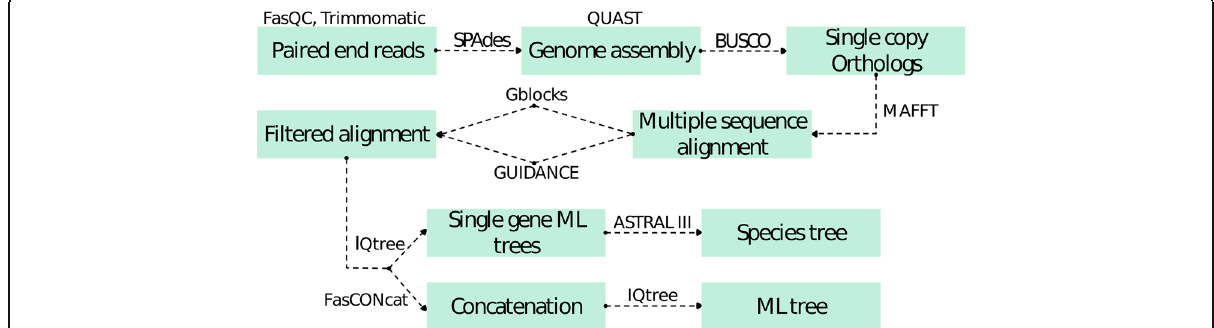
Fig. 1 Flow chart reporting the bioinformatic pipeline used for the analyses. Input and output of the pipeline are reported inside the boxes, the software used for each pipeline step is reported above or between the